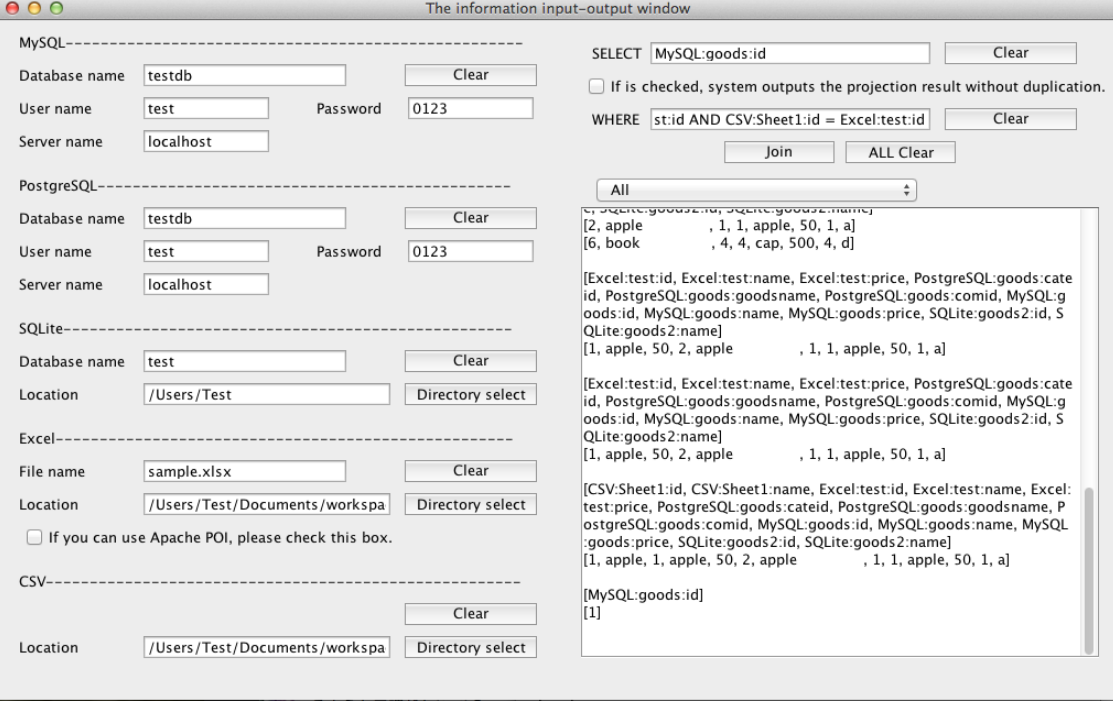
Fig. 6. Result of the join process and